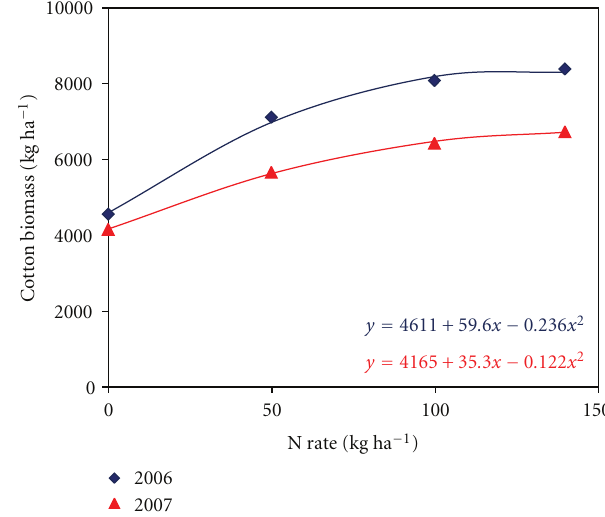
Figure 5: Cotton biomass production between first square and cutout as a ff ected by year and N rate, averaged across rye residue